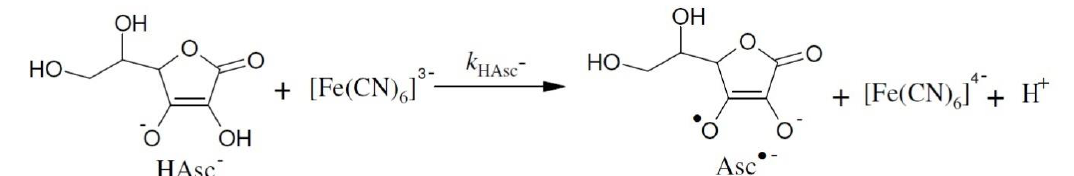
Table 2. Kinetic isotope effects, activation parameters Δ H ‡ and Δ S ‡ , isotopic differences ΔΔ H ‡ (D,H) and ΔΔ S ‡ (D,H) and ratios A H / A D in the reaction of ascorbate with hexacyanoferrate(III) Ions in the mixed water-organic cosolvent systems. Adapted from [19] and